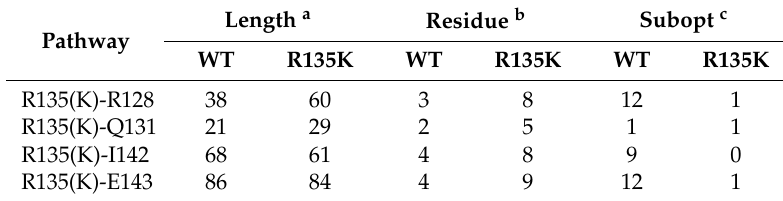
Table 4. Allosteric pathways analysis between R135K and residues important for NS1 binding. Length a Residue b Subopt c Pathway WT R135K WT R135K WT